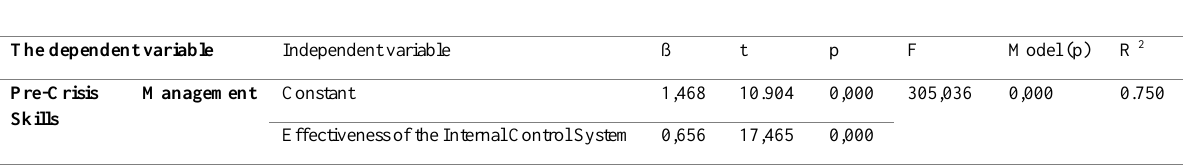
Table 5: The Effect of Internal Control System on Pre-Crisis Management